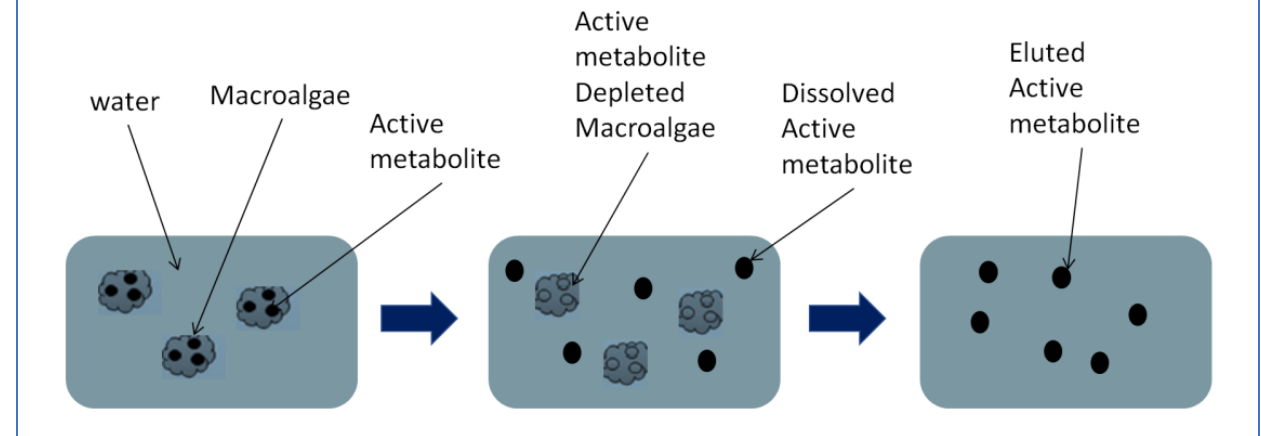
Figure 4. The process of extraction of active metabolite using subcritical water extraction (SWE, adapted from Zakaria et al. [108]).